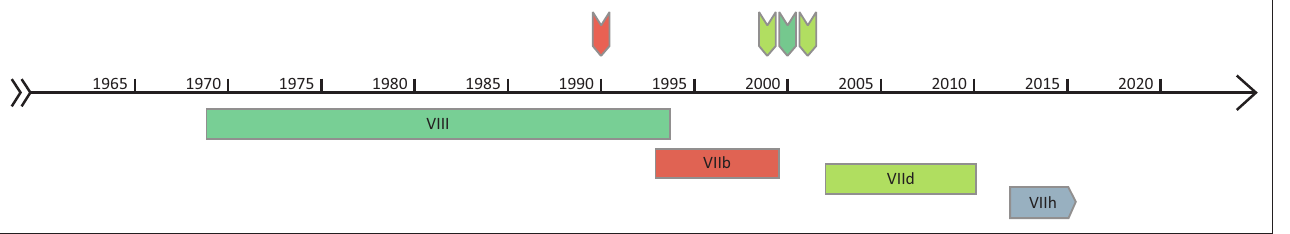
FIGURE 1: Timeline of Newcastle disease virus outbreaks in South Africa since the late 1960s, which were caused by successive outbreaks of genotypes VIII, VIIb, VIId and VIIh,